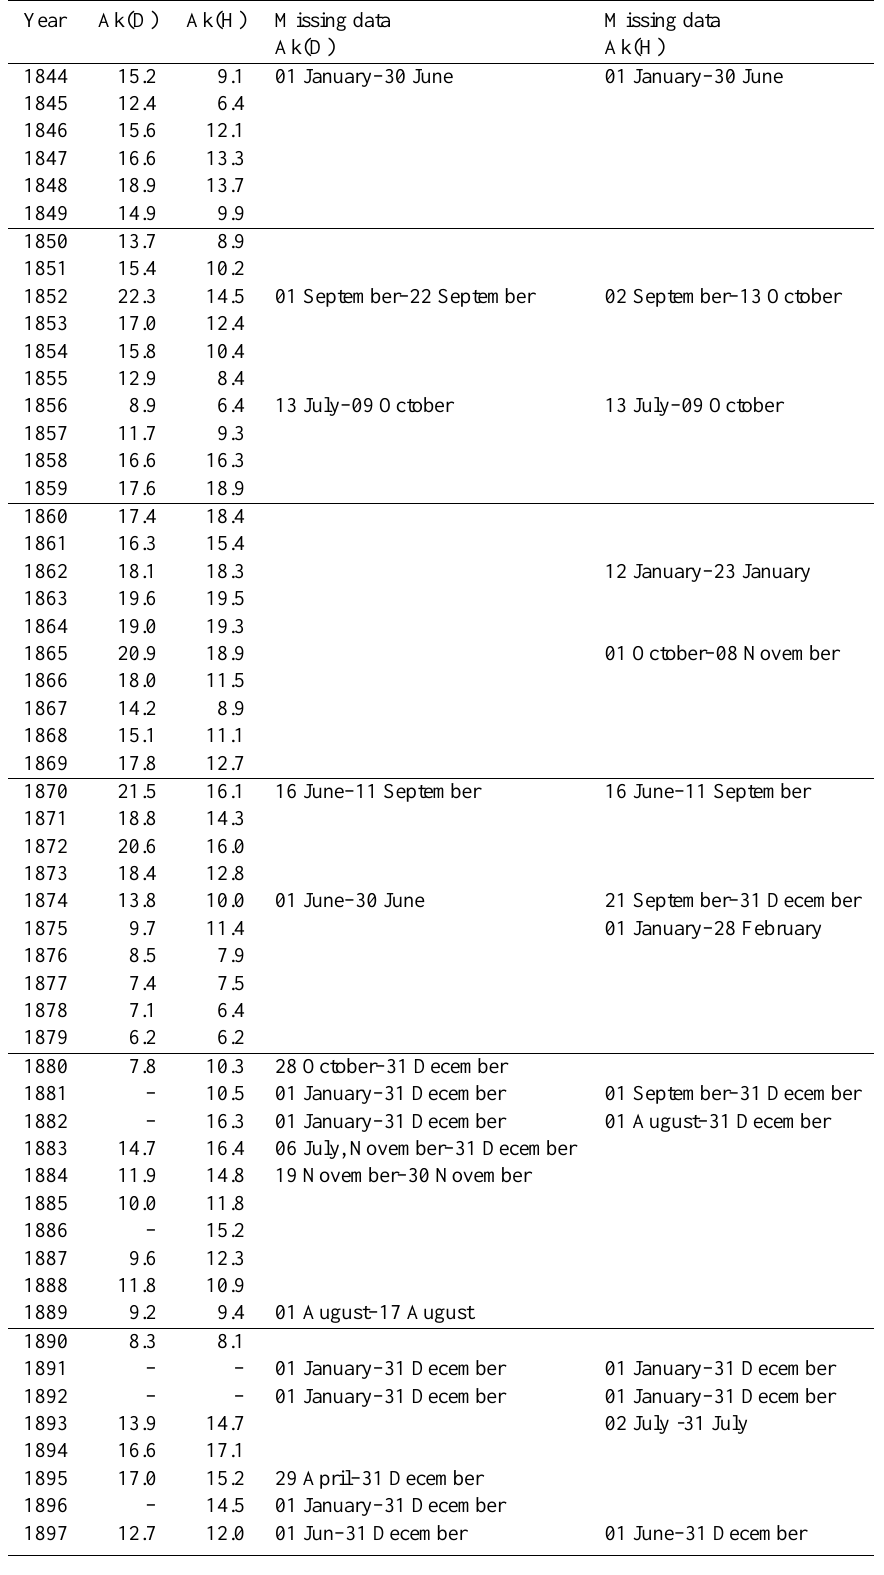
Table 1. Annual means of geomagnetic activity indices Ak(D) and Ak(H) , 1844–1897 calculated from the Helsinki observatory data. The dates of major data gaps are